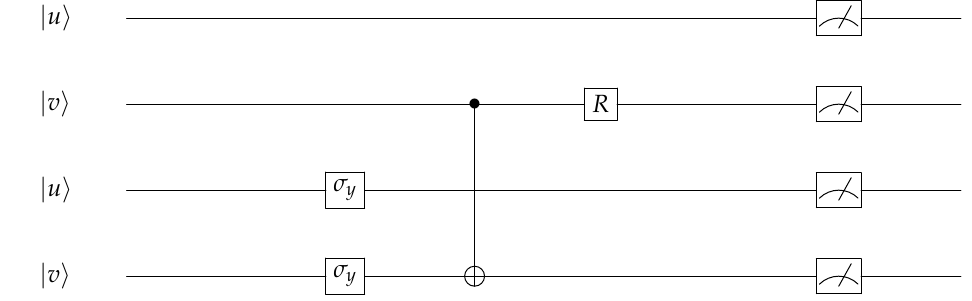
Figure 3. The circuit model of Romero et al. [54] protocol to measure the entanglement between two qubits defined by the state given by Equation (2). By feeding two copies of the state given by Equation (2) to this circuit model. The protocol applies a controlled-not ( CNOT ) gate between the qubits indexed by 2 and 4, respectively. The σ y gate is applied on the third and fourth qubits and followed by the rotation gate R , therefore the measurement process is performed on the four qubits.